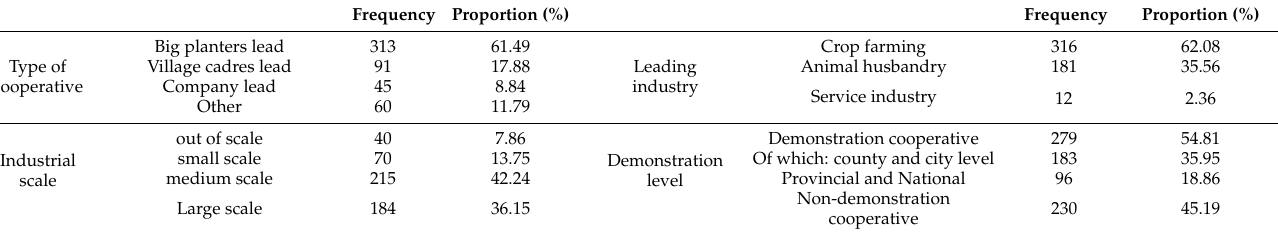
Table 1. Basic statistics of sample